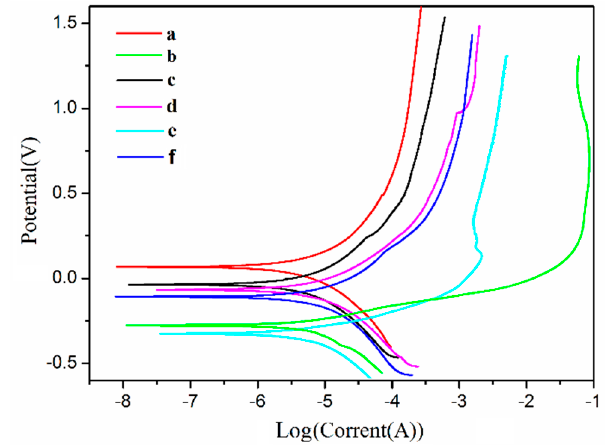
Figure 13. Tafel curves of the TO / TMMP-TMTGE self-healing coating material ( a ) in the original state, and after ( b ) scratching and ( c ) healing, and the TMMP-TMTGE self-healing coating material ( d ) in the original state, and after ( e ) scratching and ( f ) healing.